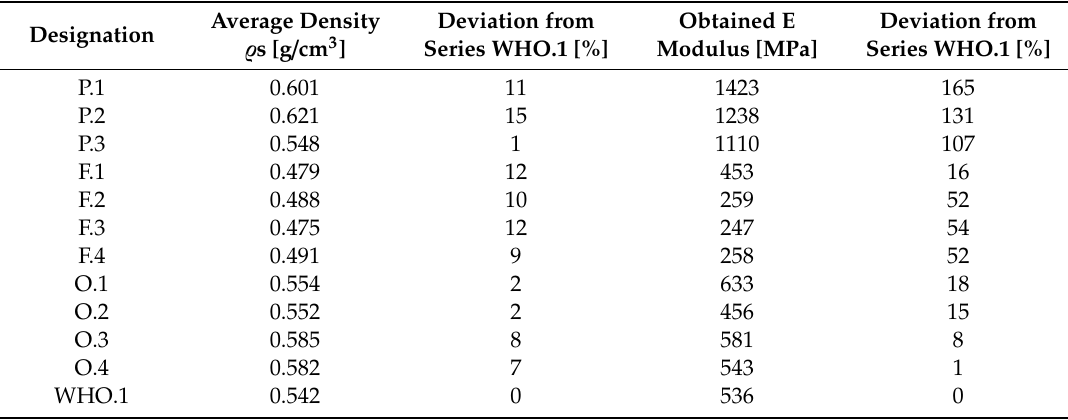
Table 6. Density and modulus of elasticity obtained for the